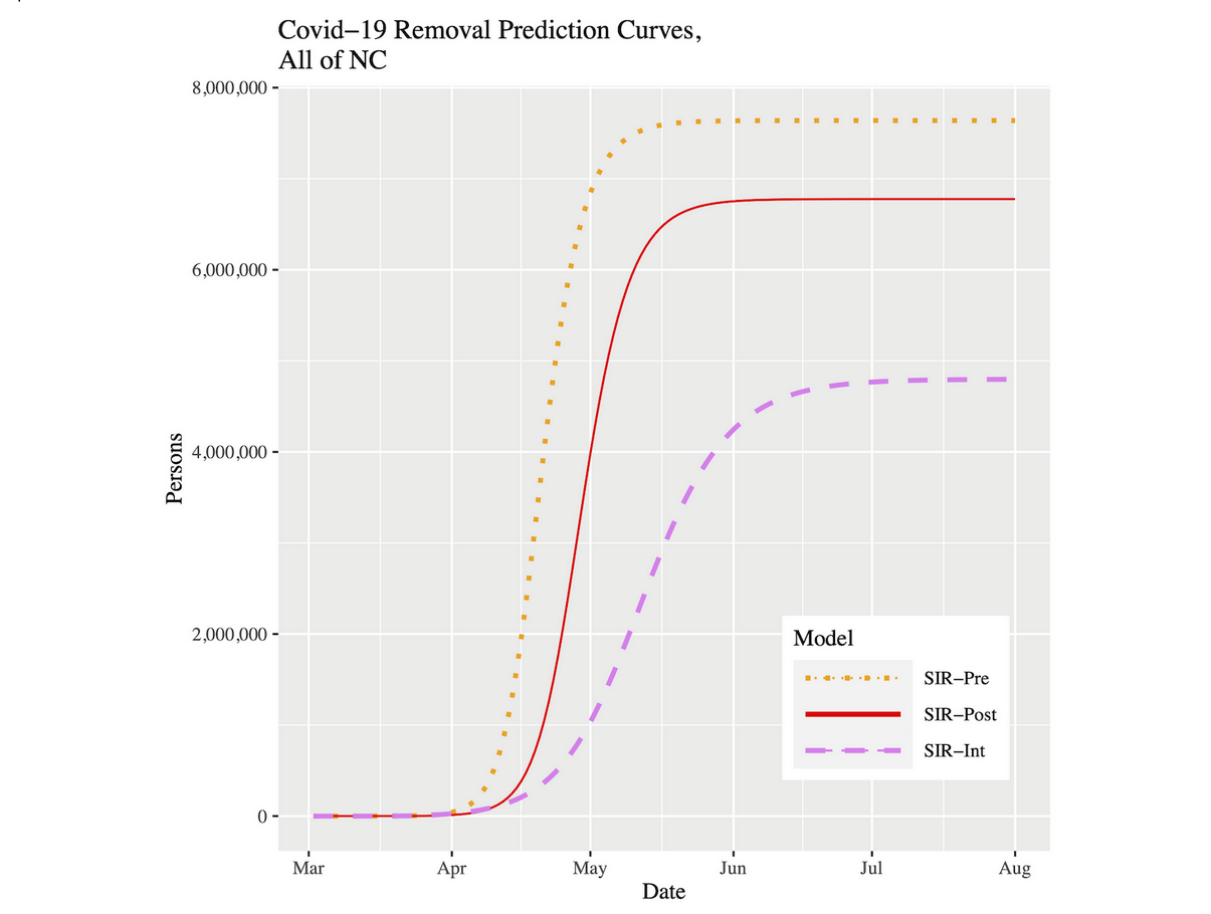
Figure 9. Removal prevalence prediction curves for NC up to August 1, 2020. COVID-19: coronavirus disease; NC: North Carolina; SIR: